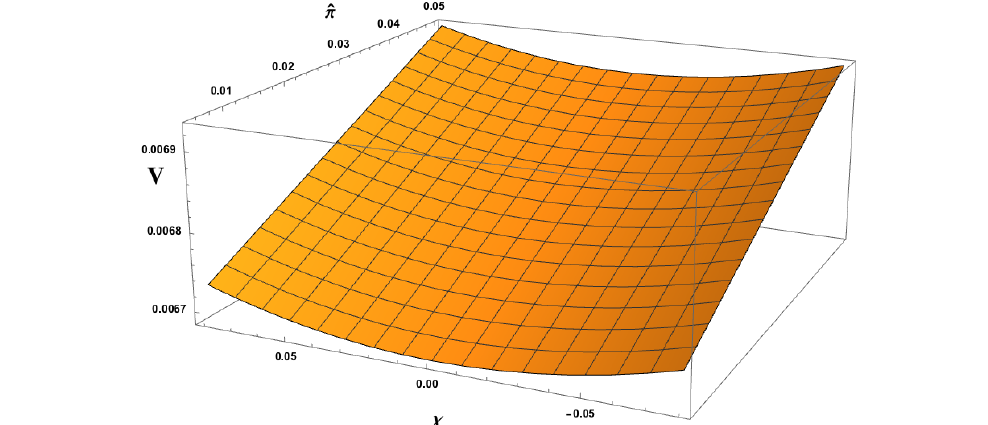
Figure 4. Plot of the potential energy V when the inequalities given in the Summary of Constraints above are satis(cid:12)ed. Here, ( c 1 ; c 2 ; c 3 ; c 4 ) = ( (cid:0) 1 : 00 ; 0 : 60 ; (cid:0) 0 : 22 ; 0 : 46). We note the positive slope